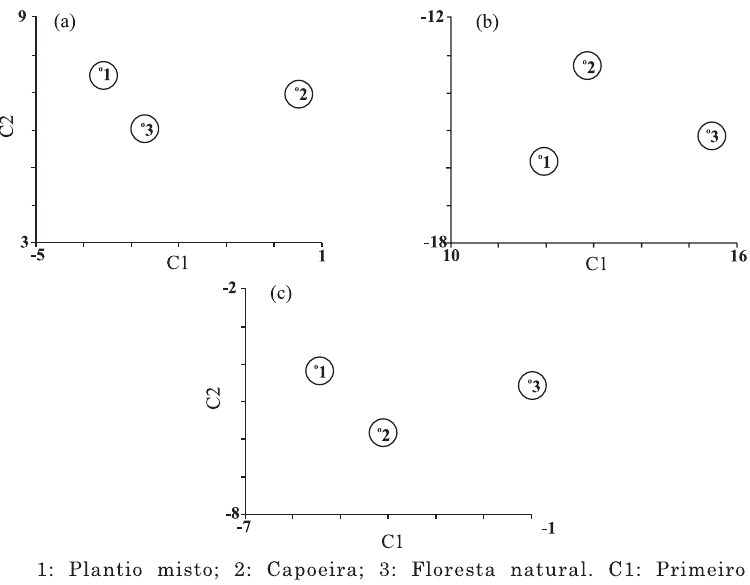
4. Dispersão gráfica em relação aos dois primeiros componentes principais, com base nas variáveis de intensidade da ciclagem bioquímica (a) e biogeoquímica (b) de N, P, K, Ca e Mg e do balanço (c) de carbono e nutrientes de diferentes coberturas florestais no sudeste da